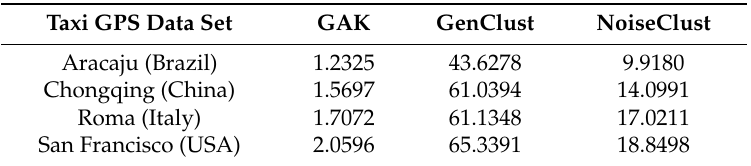
Table 6. Overall average computational times (in minutes) of the clustering algorithms for four taxi GPS data